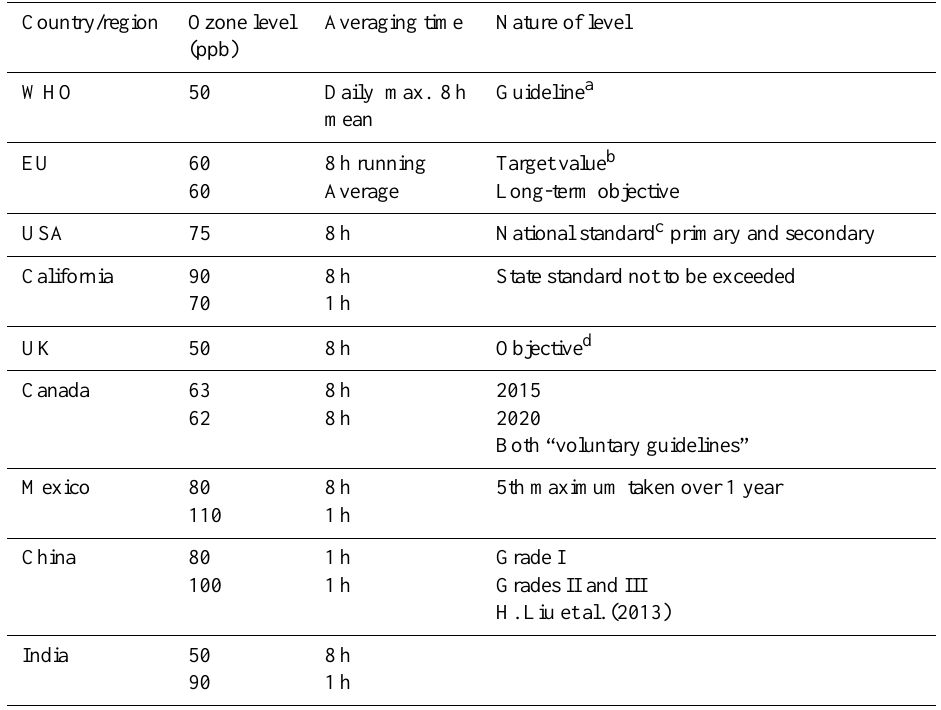
Both “voluntary guidelines”